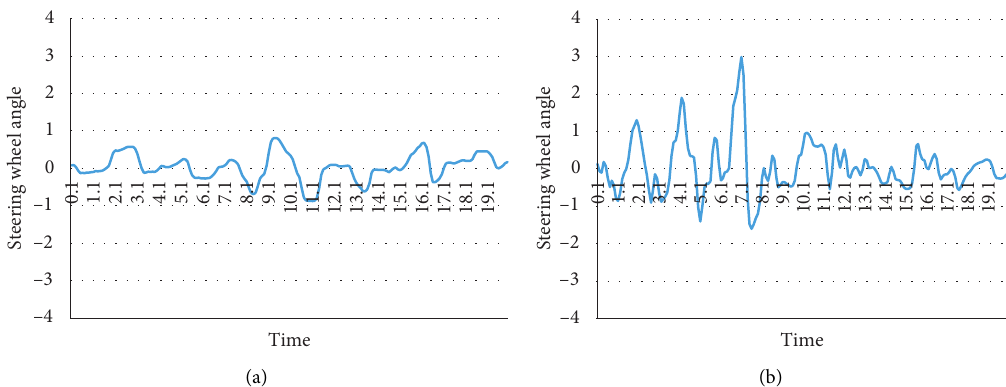
Figure 2: Observed movement of steering wheel. (a) Movement of steering wheel in a stable situation. (b) Movement of steering wheel after